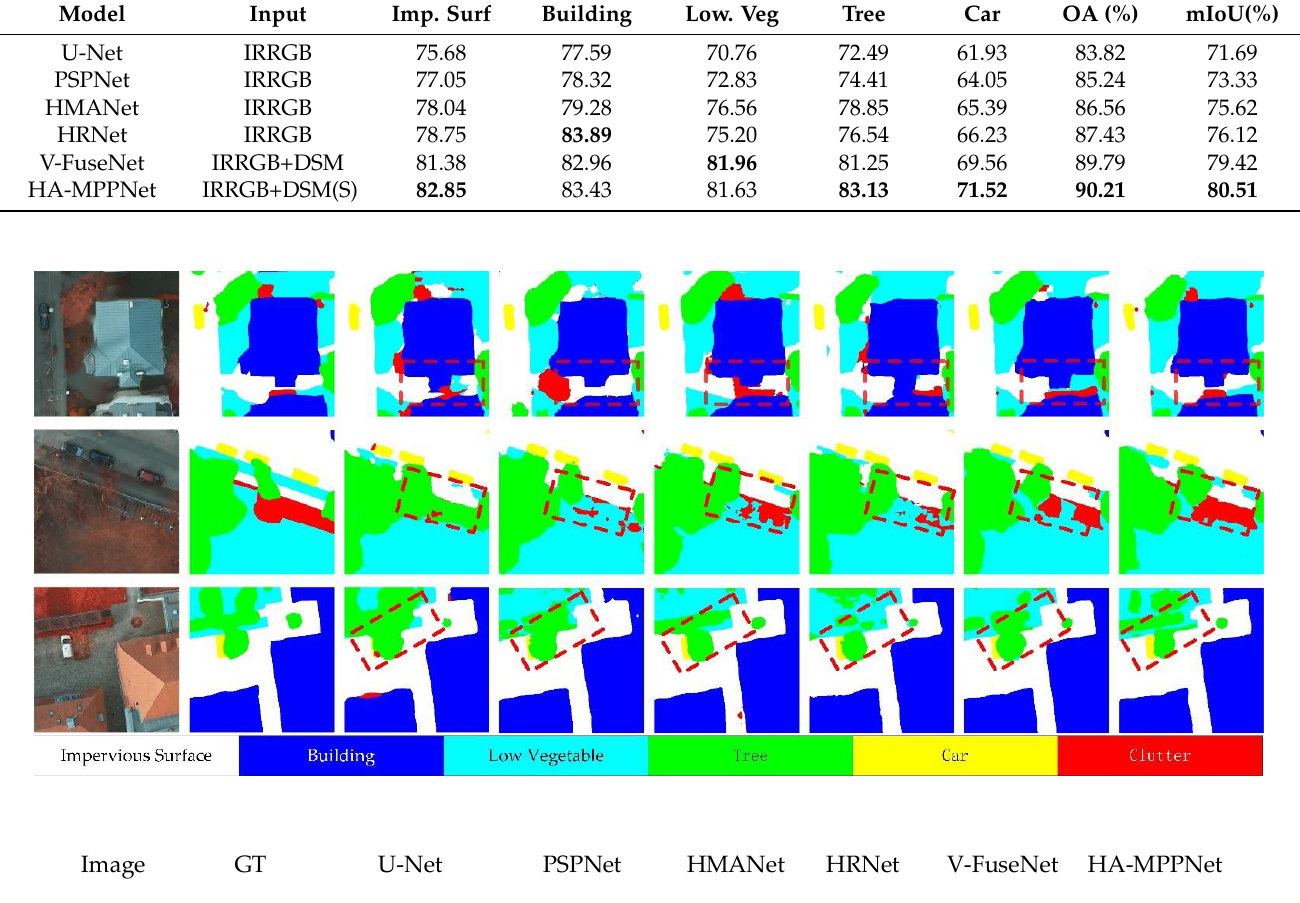
Figure 8. Selected samples of the segmentation maps on the Postam dataset.